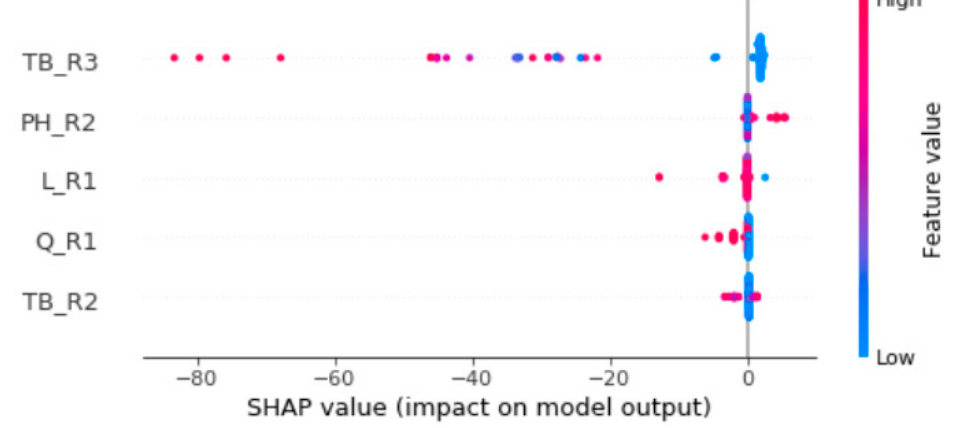
Figure 7. SHAP summary